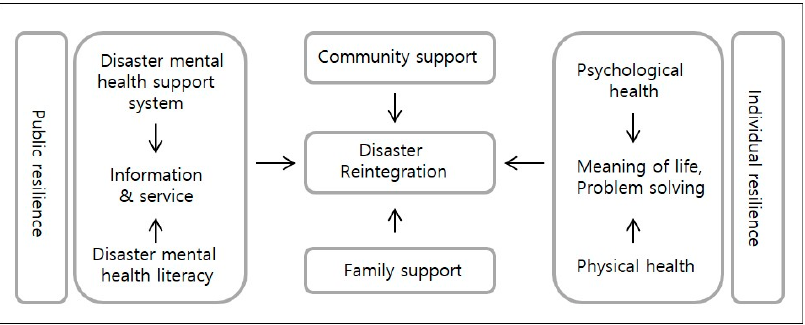
Figure 4. Disaster reintegration model.